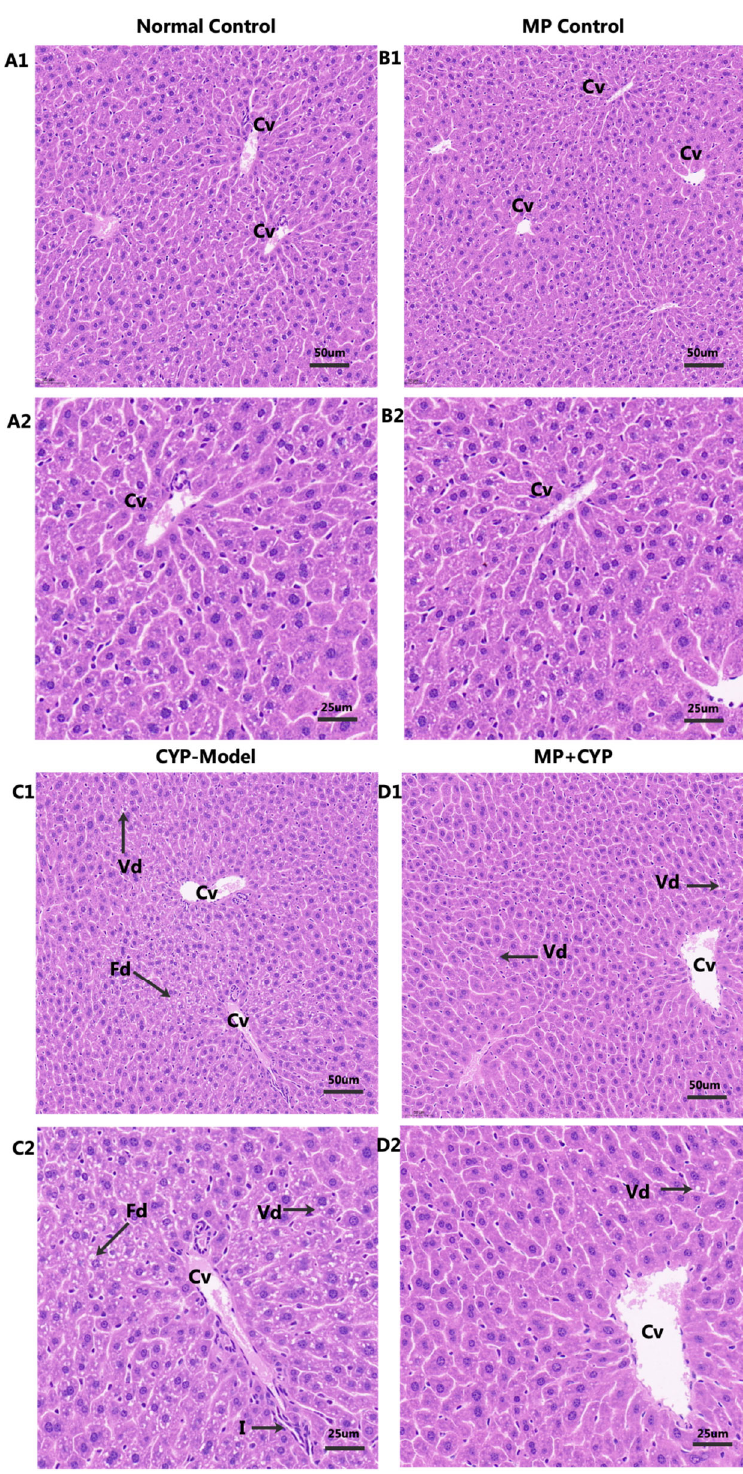
Figure 3. Histopathological observation of liver slices in the Normal Control, MP Control, CYP Model, and MP+CYP groups. Central veins (Cv) were clearly visible in all groups. The Normal Control group ( A1 and A2 ) and MP Control group ( B1 and B2 ) showed normal hepatic chords and lobules. The livers of the CYP Model ( C1 and C2 ) and MP+CYP ( D1 and D2 ) groups showed pathological changes of varying degrees. The CYP Model group ( C1 and C2 ) showed vacuolar degeneration (Vd, arrow), fatty degeneration (Fd, arrow), and inflammatory cellular infiltration (I, arrow). In addition, the MP+CYP group ( D1 and D2 ) showed slight vacuolar degeneration (Vd, arrow). The images depict staining with H&E at 200 × and 400 ×